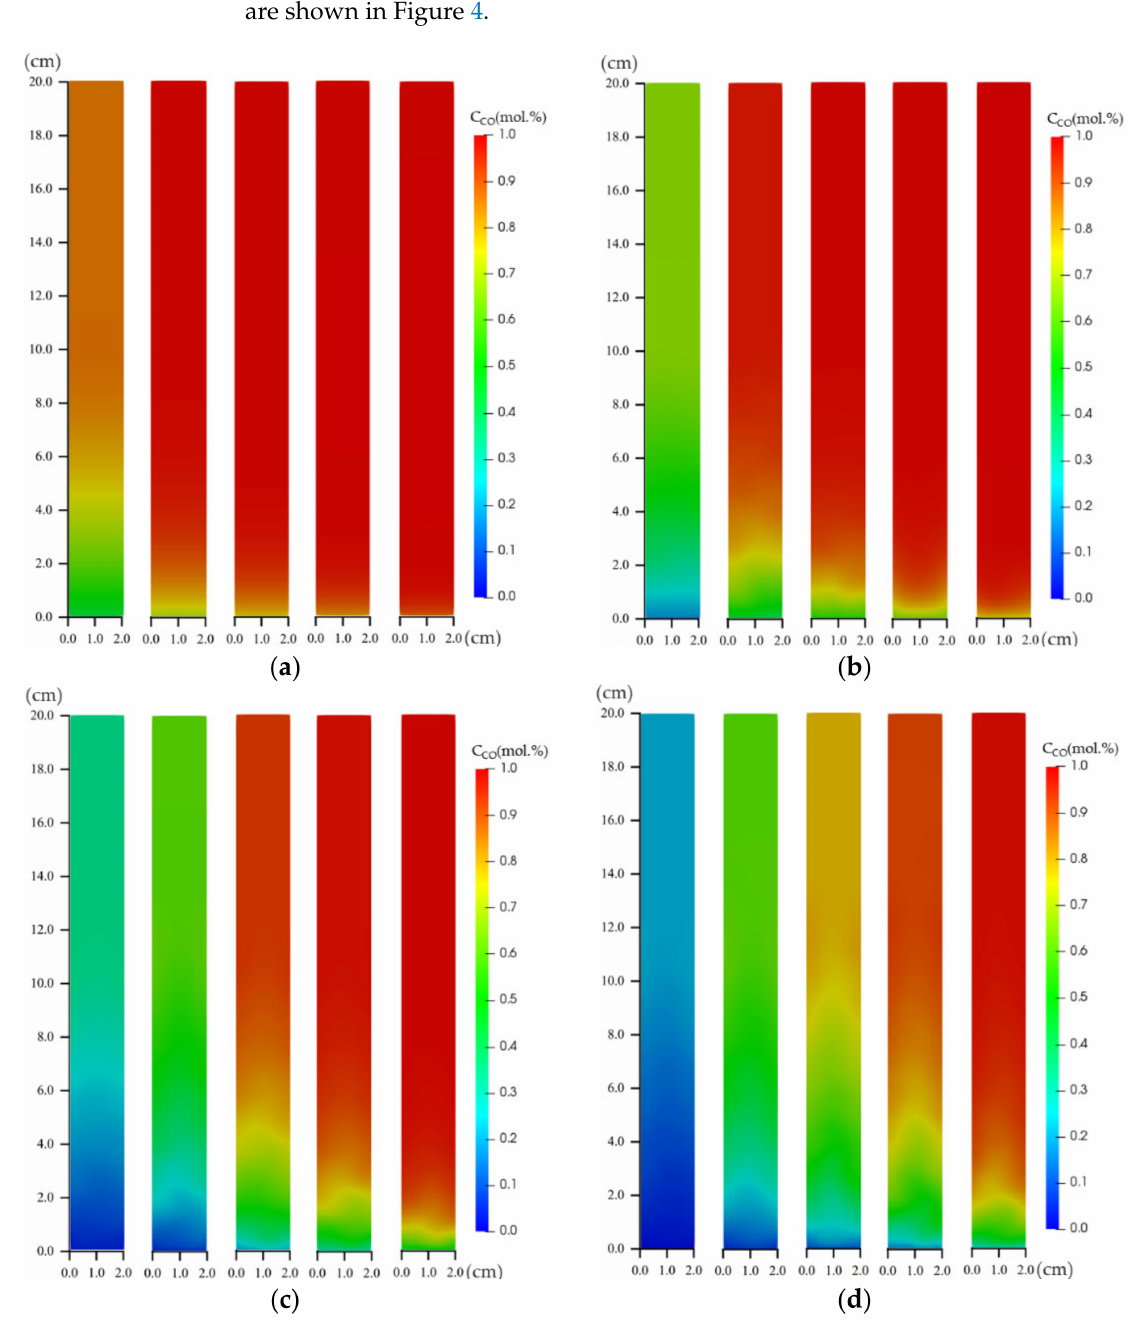
Figure 4. CO molar fraction distribution in fluidized bed gasifiers with different active site densities A s , 7.2 × 10 − 6 mol/m 2 , 3.6 × 10 − 5 mol/m 2 , 7.2 × 10 − 5 mol/m 2 , 1.44 × 10 − 4 mol/m 2 , 3.6 × 10 − 4 mol/m 2 . ( a ) Fixed bed with v CO ( b ) Delayed bubbling bed with v CO = 0.5 cm/s, ( c ) Bubbling bed with v CO 2 ,in v CO = 3.0 2 ,in